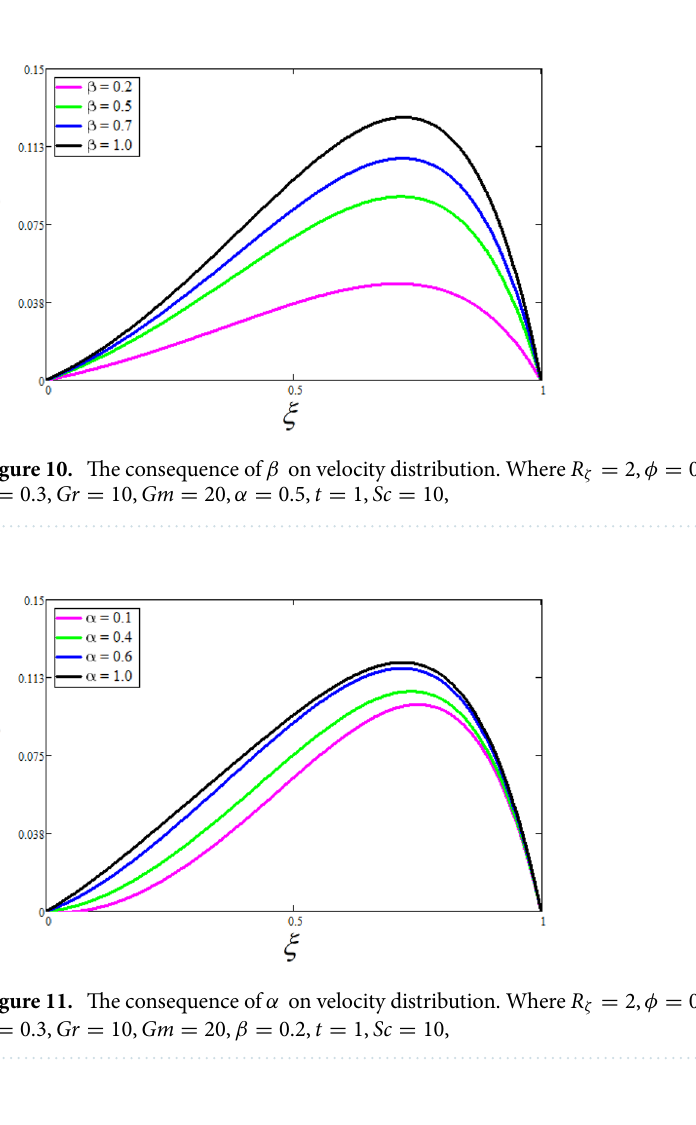
Figure 9. The consequence of angle of plate inclination on velocity distribution. Where R